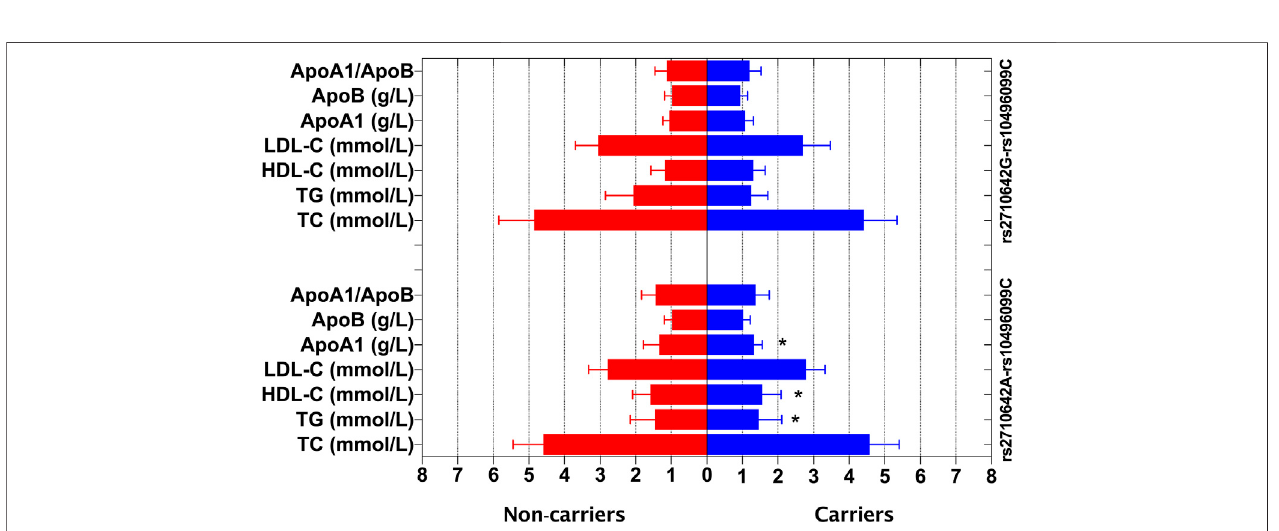
FIGURE 3 | Associations between the EHBP1 haplotypes and serum lipid levels in the control group. * p < 0.025 was considered statistical signi fi cance after the Bonferroni correction for two